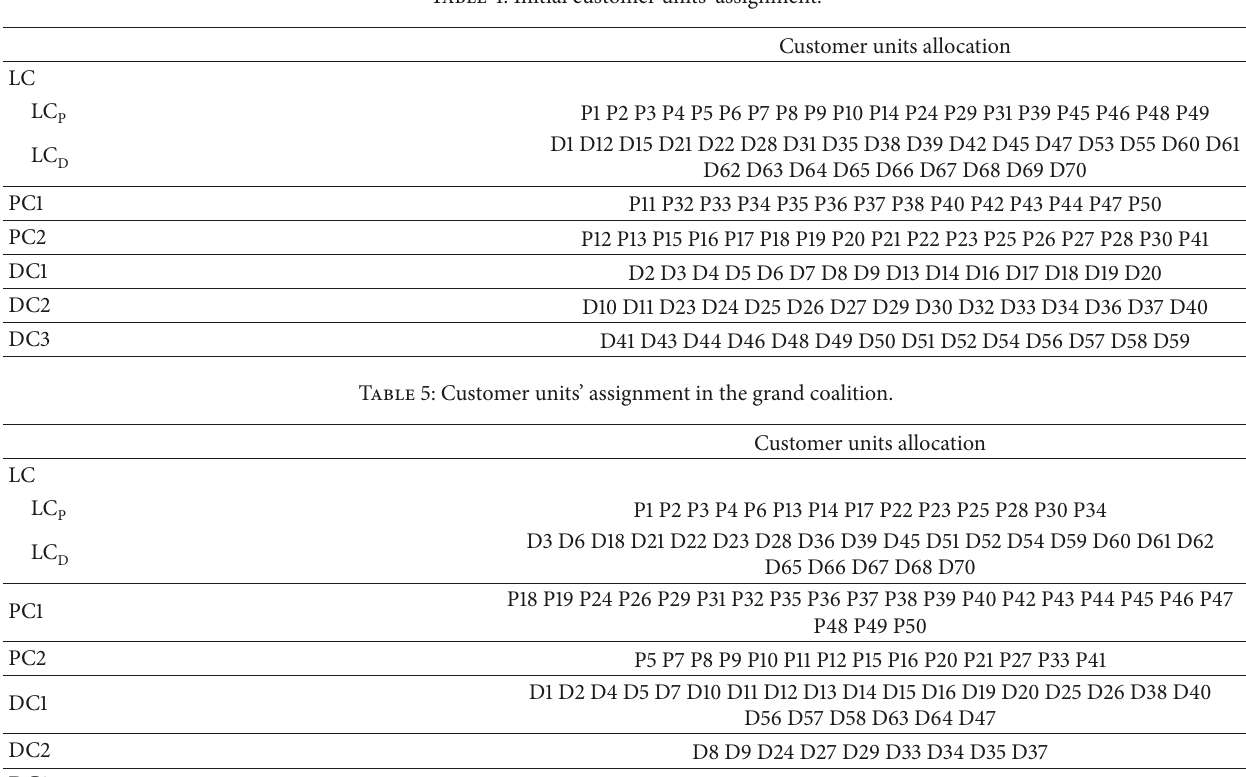
Table 4: Initial customer units’ assignment.